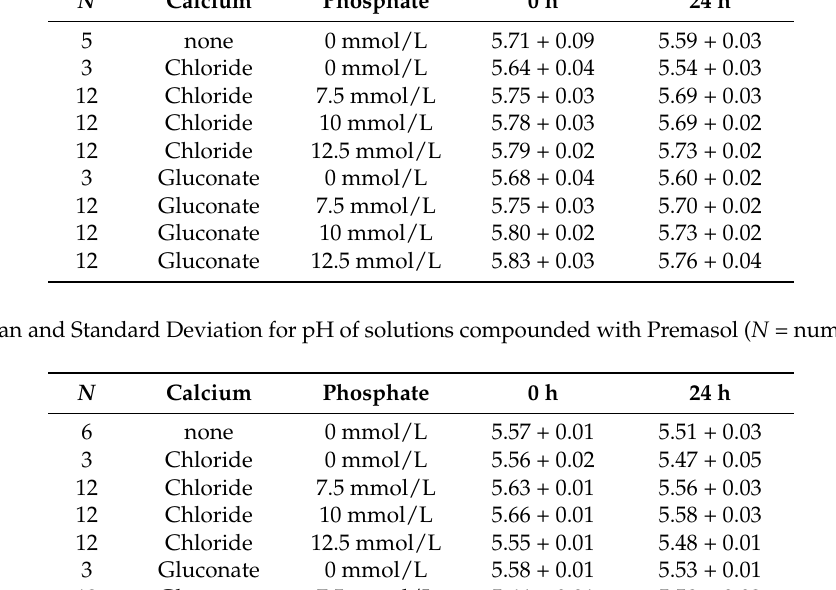
Table 2. Mean and Standard Deviation for pH of solutions compounded with TrophAmine ( N = number of bags). N